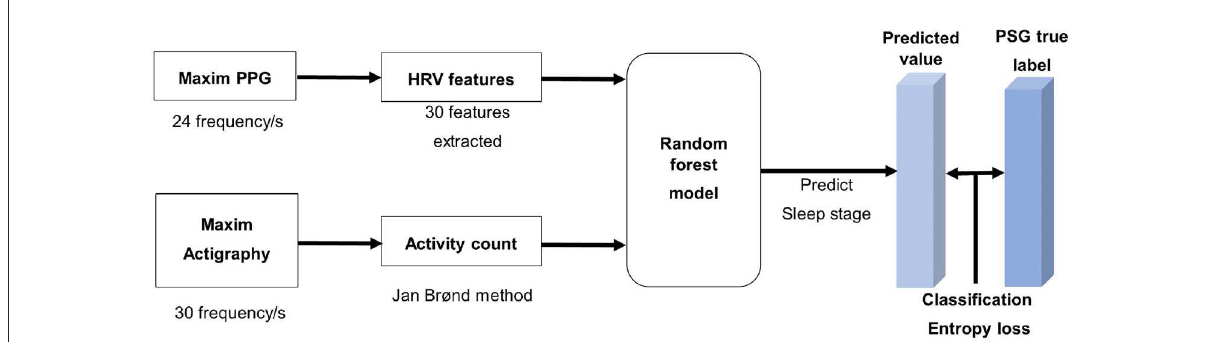
FIGURE1 This is a process flow diagram of sleep stage classification